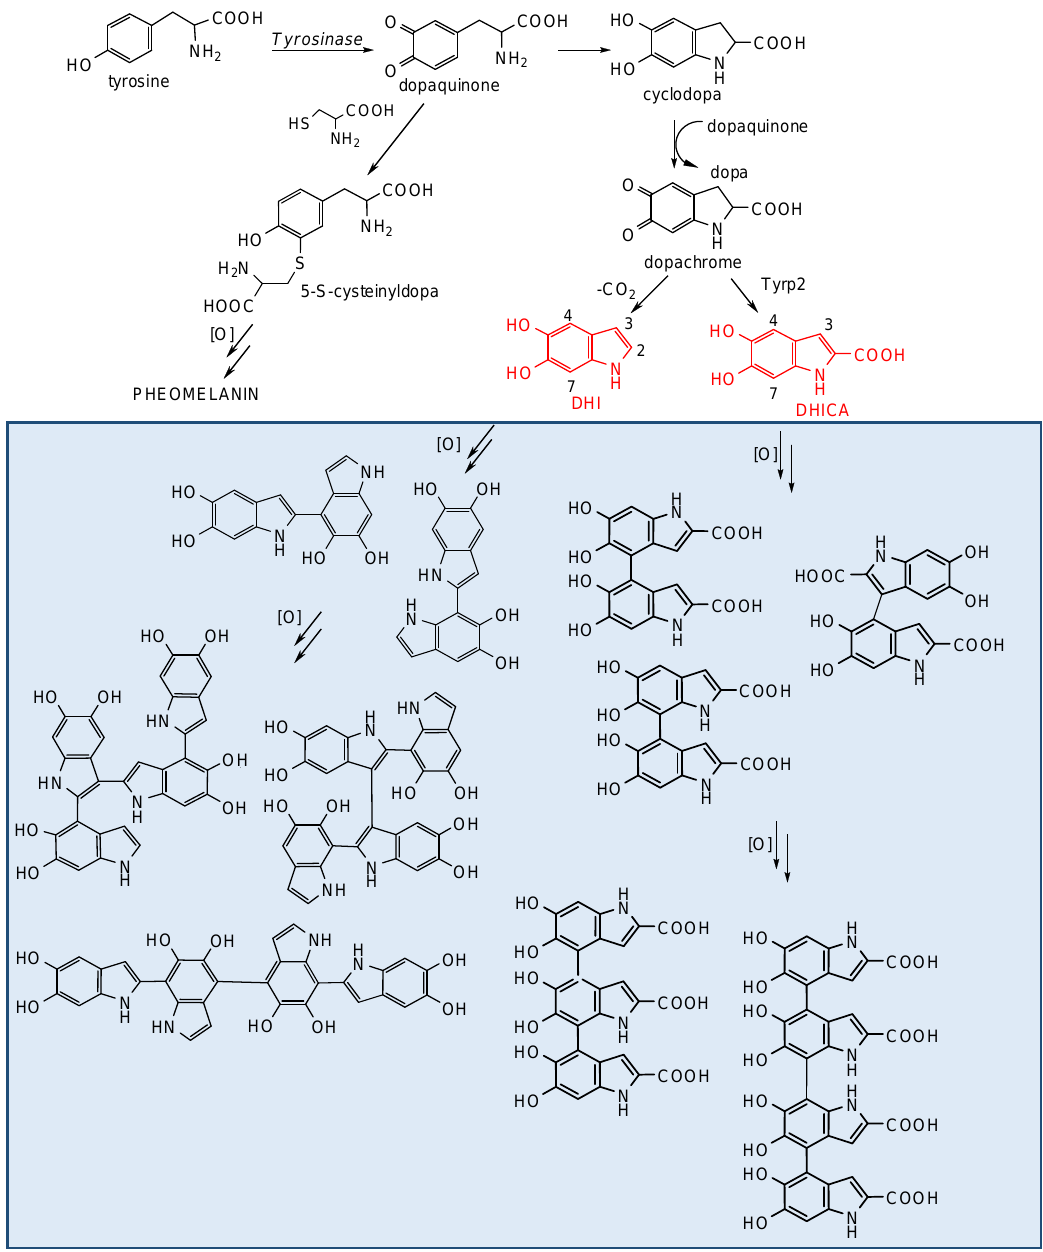
Figure 1. Schematic overview of melanogenesis. The late stages beyond formation of 5,6-dihydroxyindoles DHI and DHICA (in red) are highlighted and the mode of oxidative coupling exemplified by the structures of the main oligomers so far identified [4,33,34].